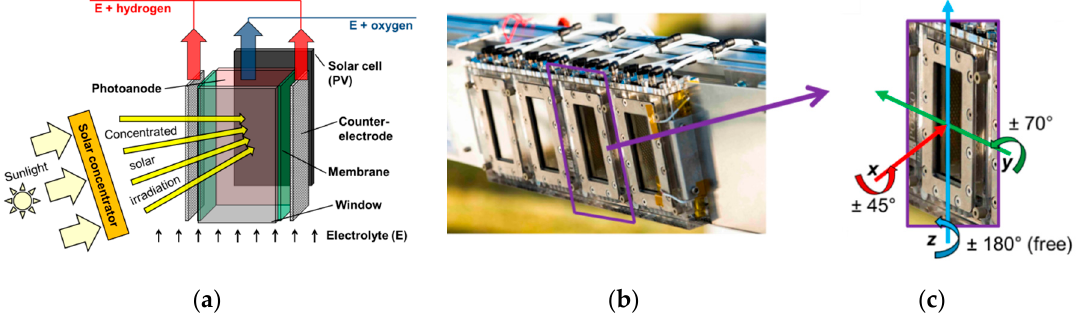
Figure 1. ( a ) Illustration of the main parts of the CoolPEC cell (without body), in particular oblong photoanode and solar cell provided with concentrated irradiation from a solar concentrator, ( b ) CoolPEC module in the focal plane of the SoCRatus and ( c ) one of the incorporated photoelectrochemical (PEC) units with a 50-cm 2 active cell area along with the reference Cartesian coordinate system and tilt constraints with respect to rotational axes.